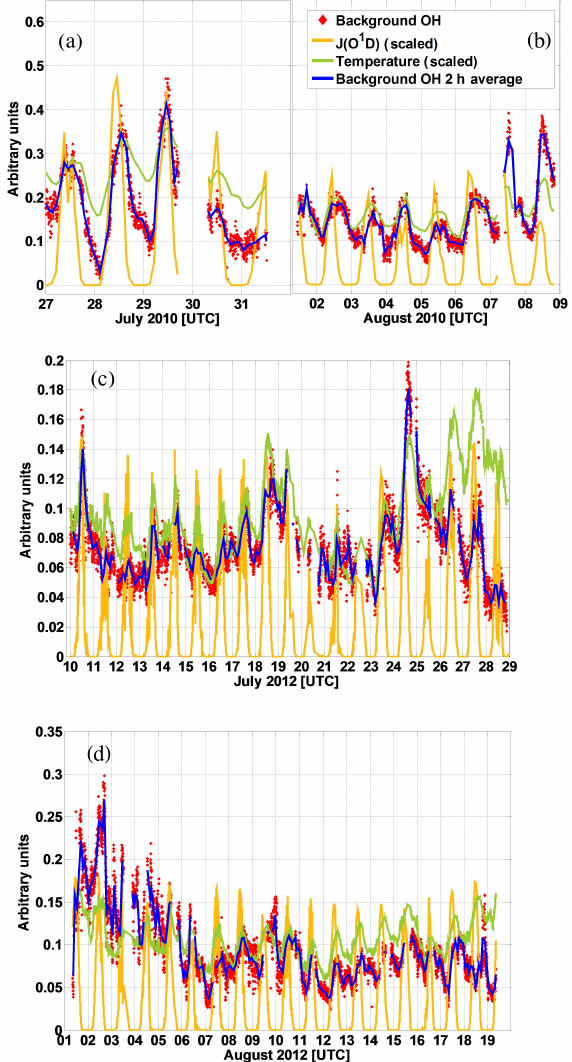
Figure 4. Background OH (red diamonds) measured during the HUMPPA-COPEC 2010 ( a , ground; b , tower) and the HOPE 2012 ( c , July; d , August) campaigns together with scaled J(O 1 D), multi- plied by 4.0 × 10 4 and 4.0 × 10 3 for HUMPPA-COPEC 2010 and HOPE 2012, respectively (orange), and scaled temperature divided by 90 and 160K for HUMPPA-COPEC 2010 and HOPE 2012, re- spectively